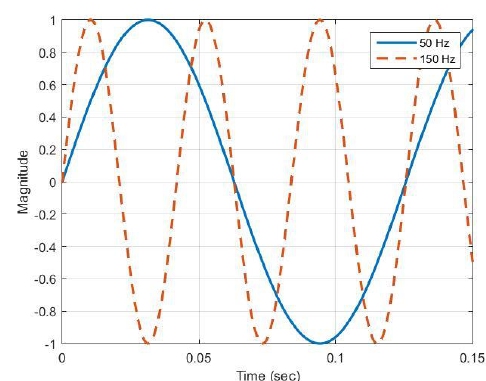
Figure A6. Sine wave frequencies 50 – 150 Hz [2,4].